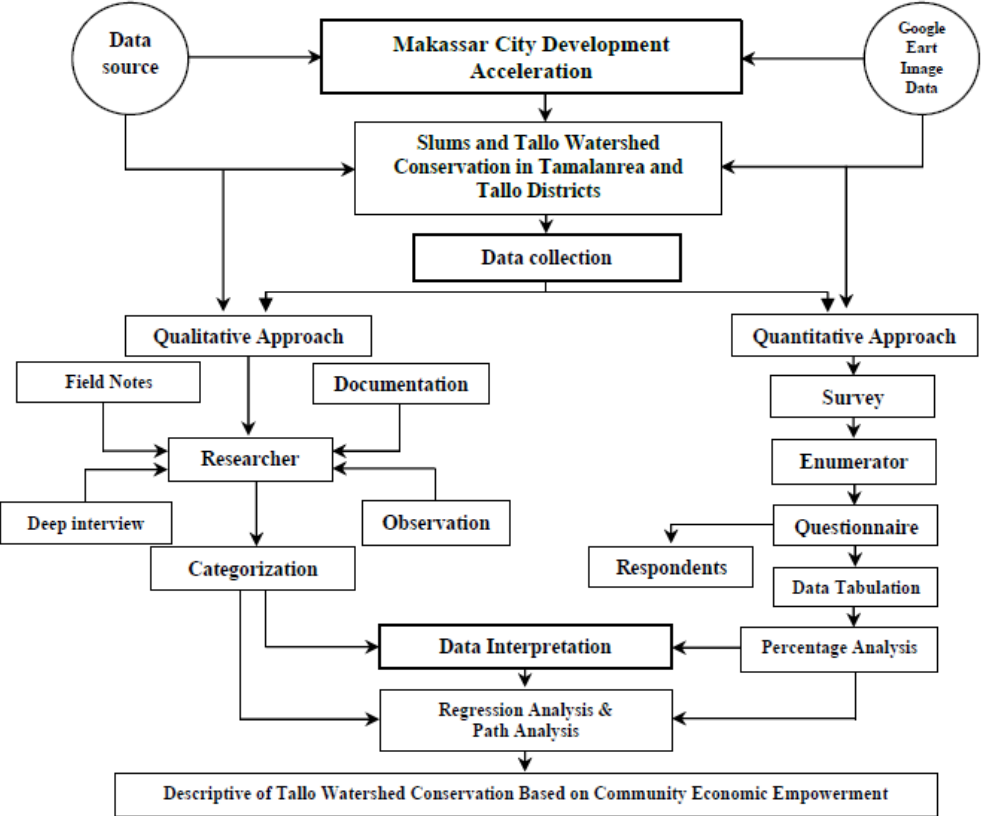
Figure 3. Research Process Flowchart, Natural Resource Conservation Based on Community Economic Empowerment. Source: author elaboration.